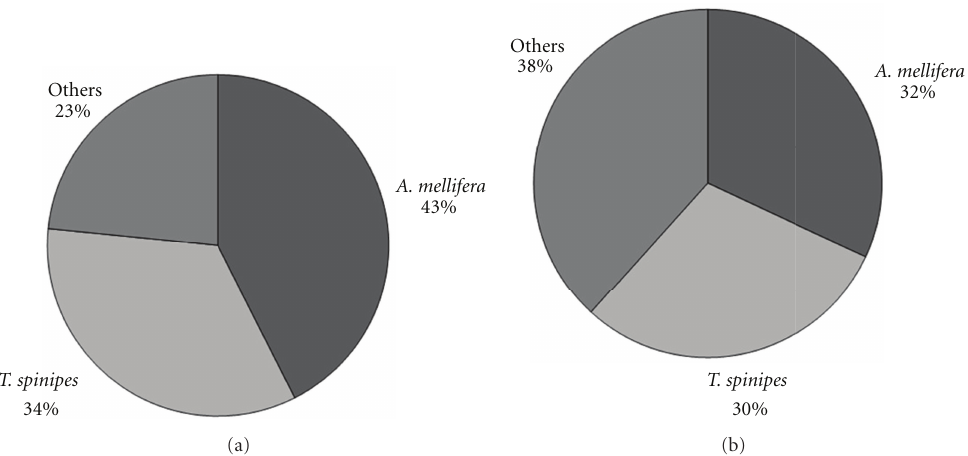
Figure 2: Percentage of Brazilian bee surveys presenting Apis mellifera or Trigona spinipes as (a) the first species with highest number of interactions and (b) the second species with highest number of